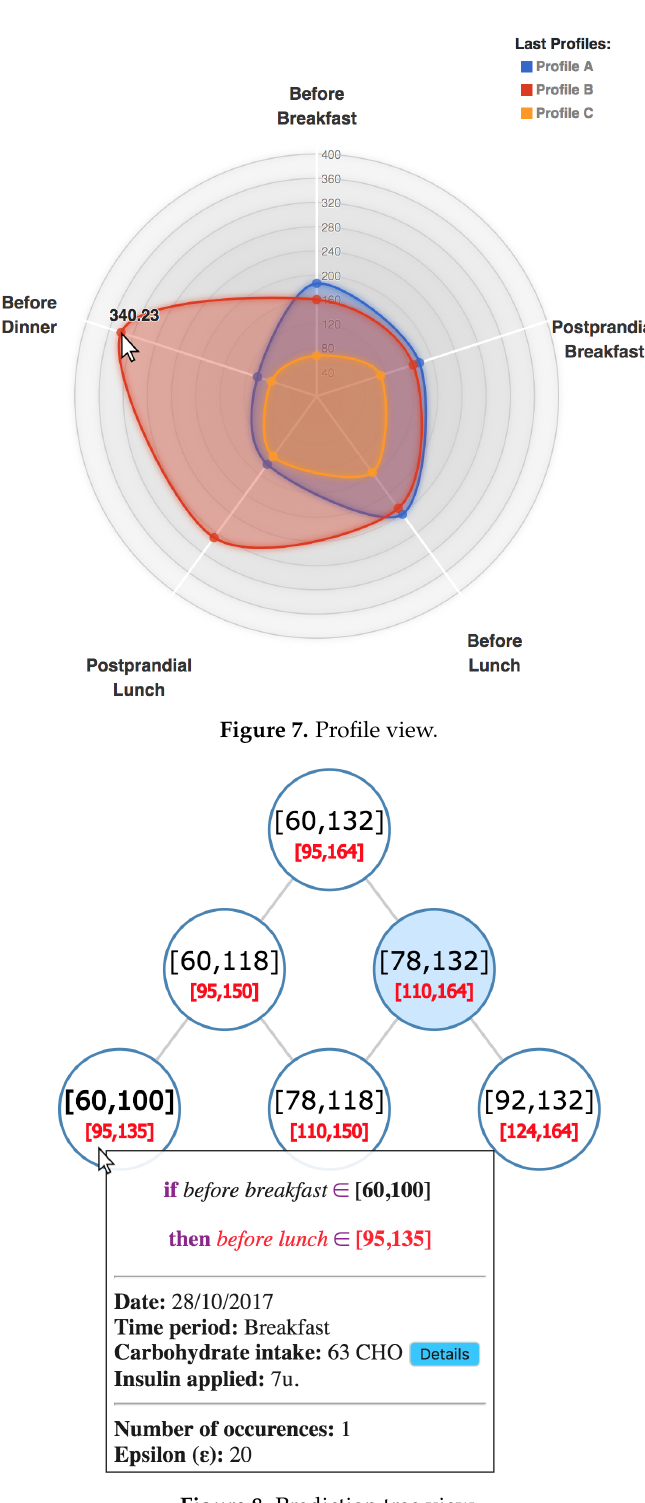
Figure 8. Prediction tree